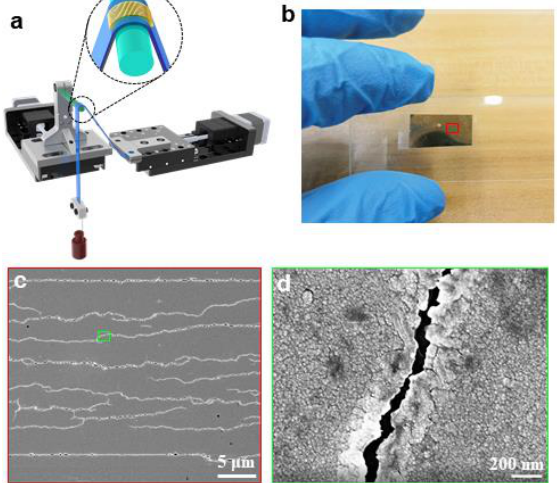
Figure 2. Fabrication of the crack-based flexible strain sensor. ( a ) The home-made instrument for manufacturing nanoscale crack on flexible PET substrate. ( b ) The crack-based strain sensor. ( c ) The nanoscale crack array on the flexible substrate. ( d ) Local enlarged image taken from ( c ) denoted by green square.